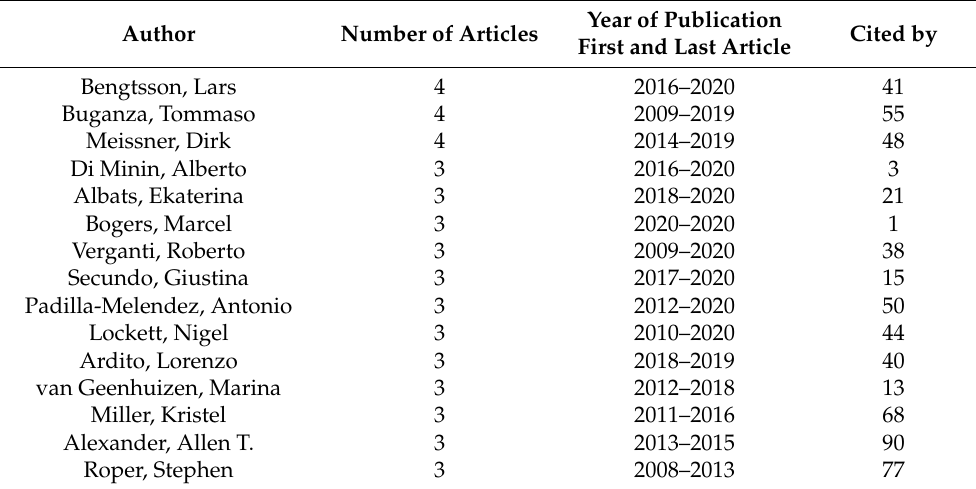
Table 2. Authors who have published three or more articles on Open Innovation and